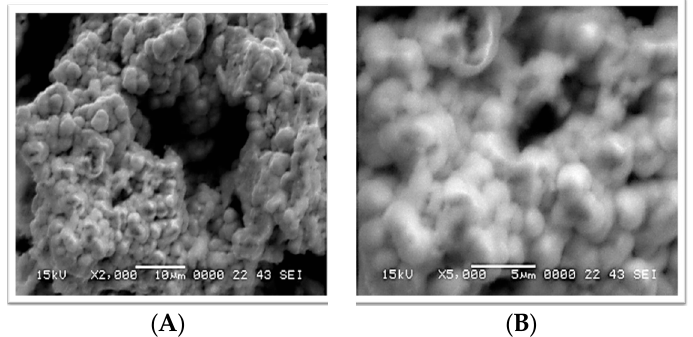
Figure 2. Scanning electron microscope images of CuO nanostructures at ( A ) low and ( B ) high magnification levels.